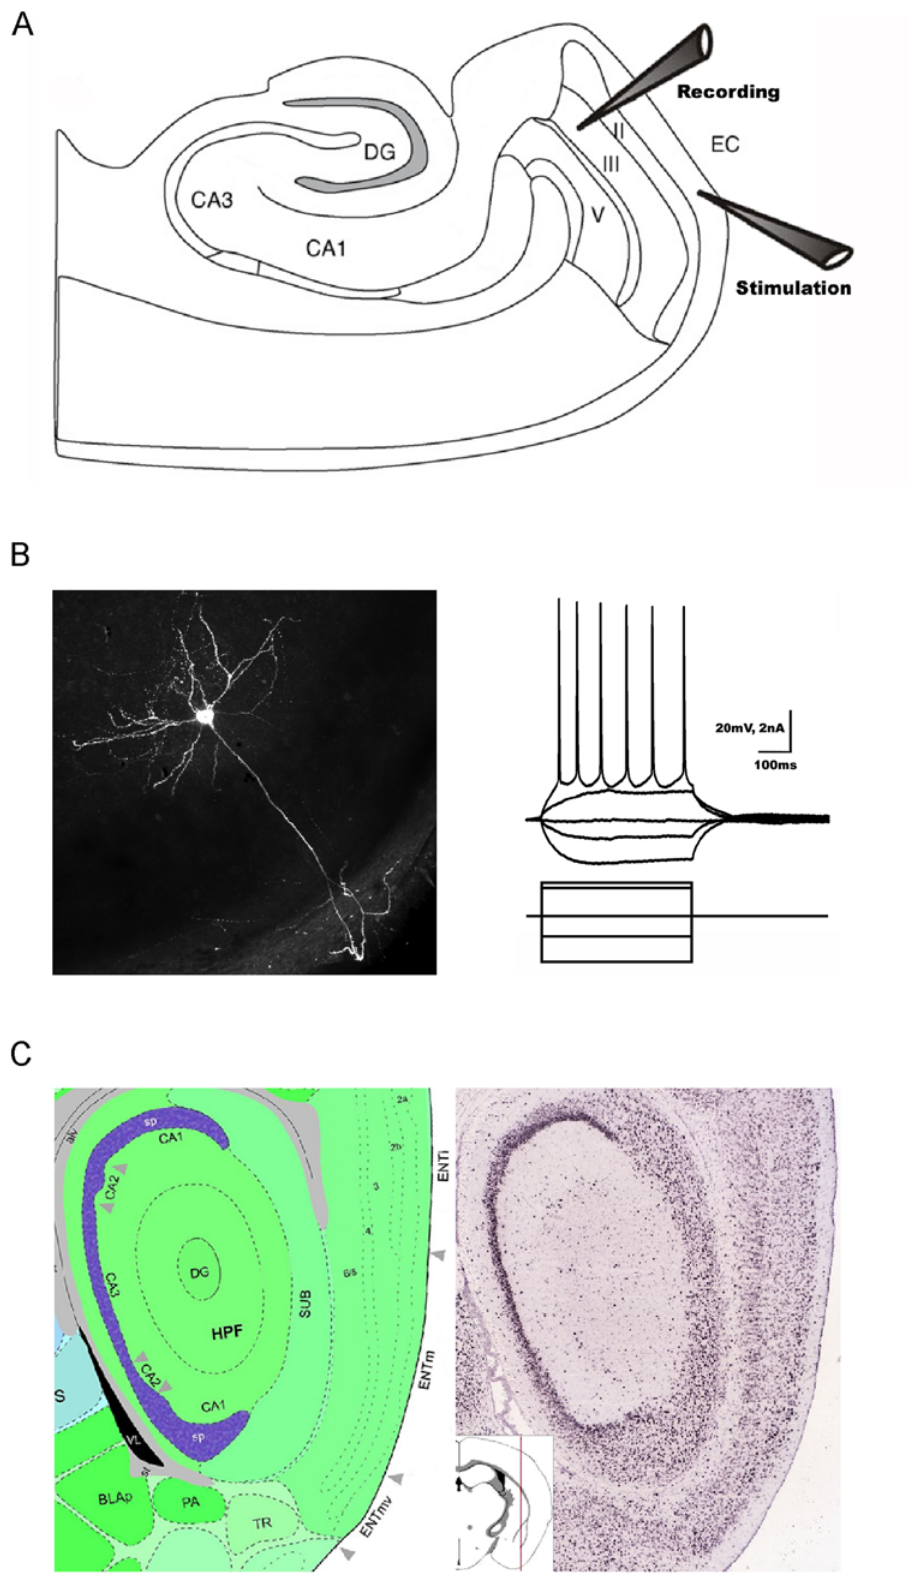
Figure 1. Layer III medial entorhinal cortex (LIII mEC) pyramidal neurons. (A) Schematic representation of the entorhinal-hippocampal combined slice used in this study with the recording electrode (Recording) in LIII mEC while stimulating (Stimulation in LI mEC) the input from the lateral entorhinal cortex. (B) Electrophysiological and morphological properties of a typical LIII mEC pyramidal neuron. (C) In situ hybridization of GluK2 subunit of kainate receptor in the mEC. Data adapted from the Allen Atlas, Allen Institute of Brain Science.